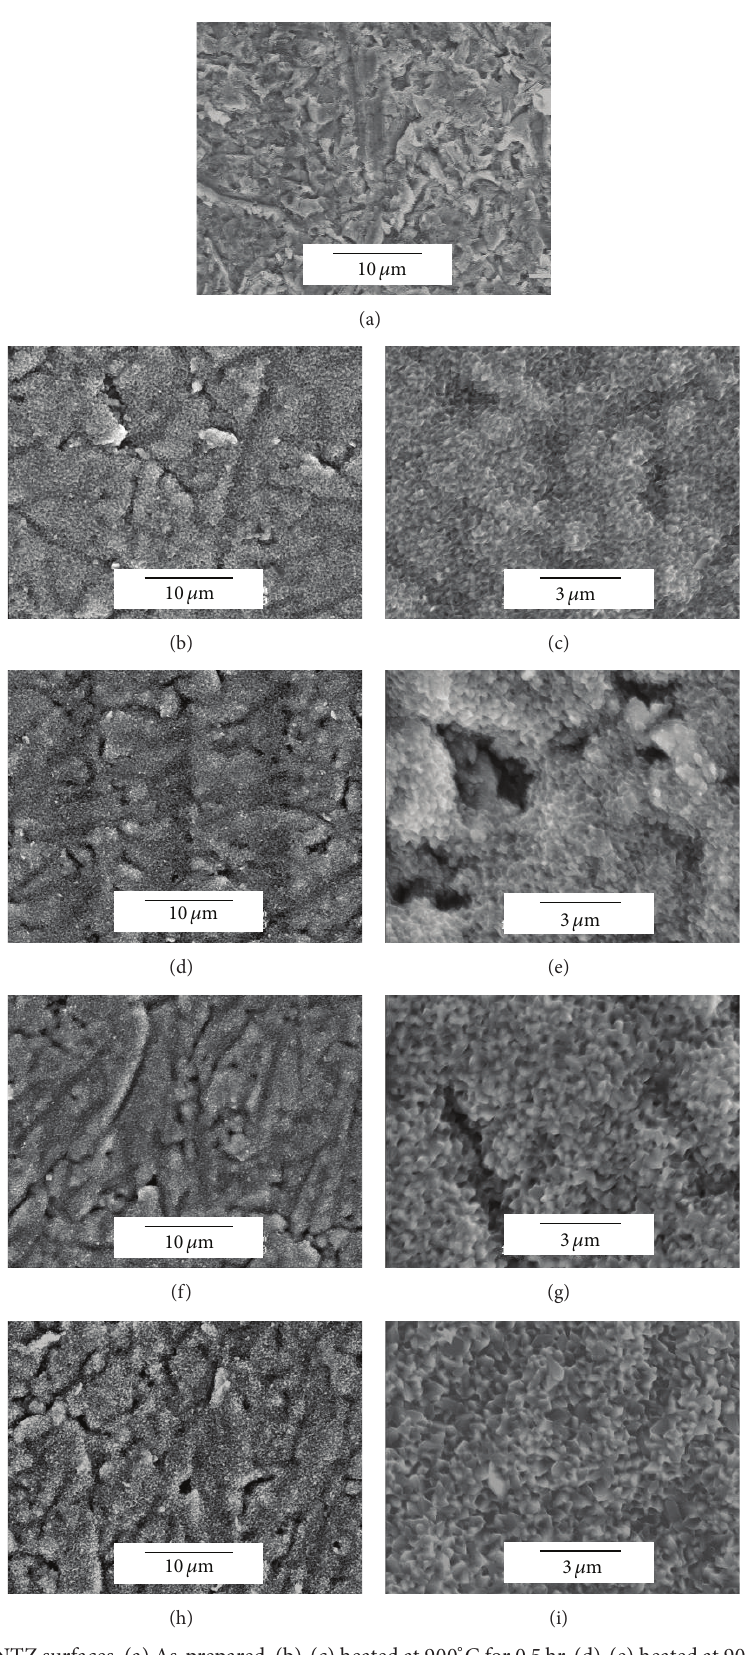
Figure 3: SEM images of TNTZ surfaces. (a) As-prepared, (b)-(c) heated at 900 ∘ C for 0.5 hr, (d)-(e) heated at 900 ∘ C for 1hr, (f)-(g) heated at 1000 ∘ C for 0.5hr, (h)-(i) heated at 1000 ∘ C for 1hr, and (c)–(i) magnified images of